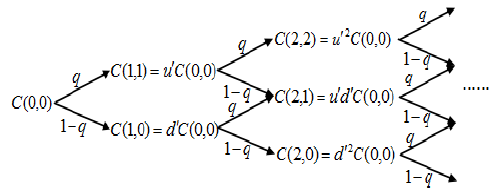
Figure 2. Binary lattice stochastic process of carbon price.